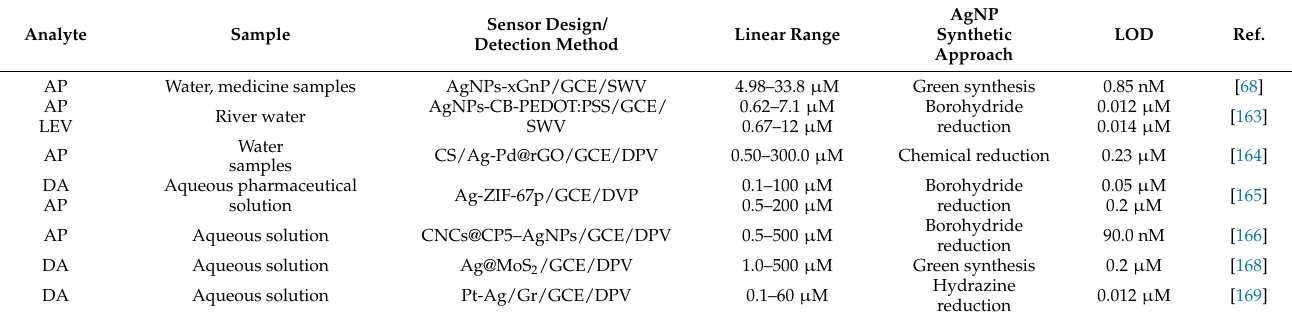
Table 4. Survey of the reviewed silver nanomaterial-based electrochemical sensors for detection of pharmaceuticals in water